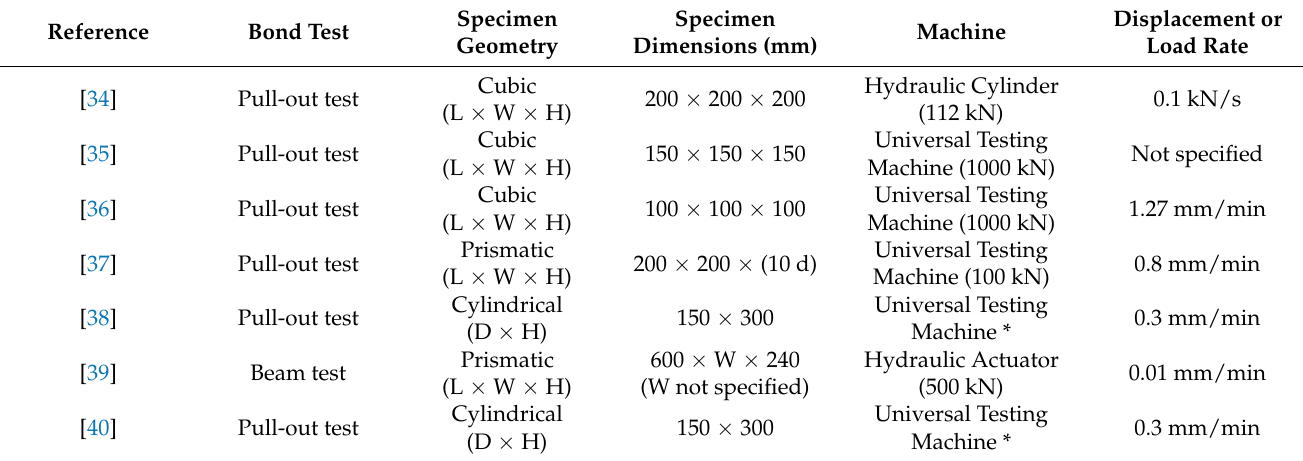
Table 3. Characteristics of bond tests and